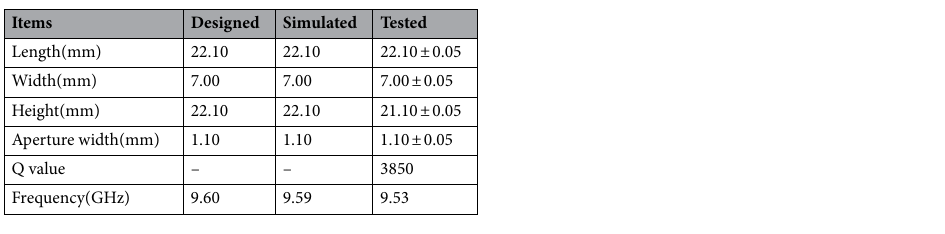
Table 1. Some tested parameters of the aperture